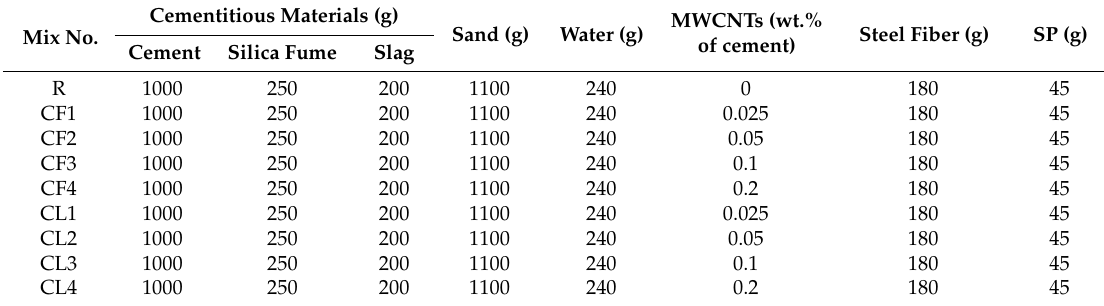
Table 3. Multi-walled carbon nanotubes-reactive powder concrete composites mixture